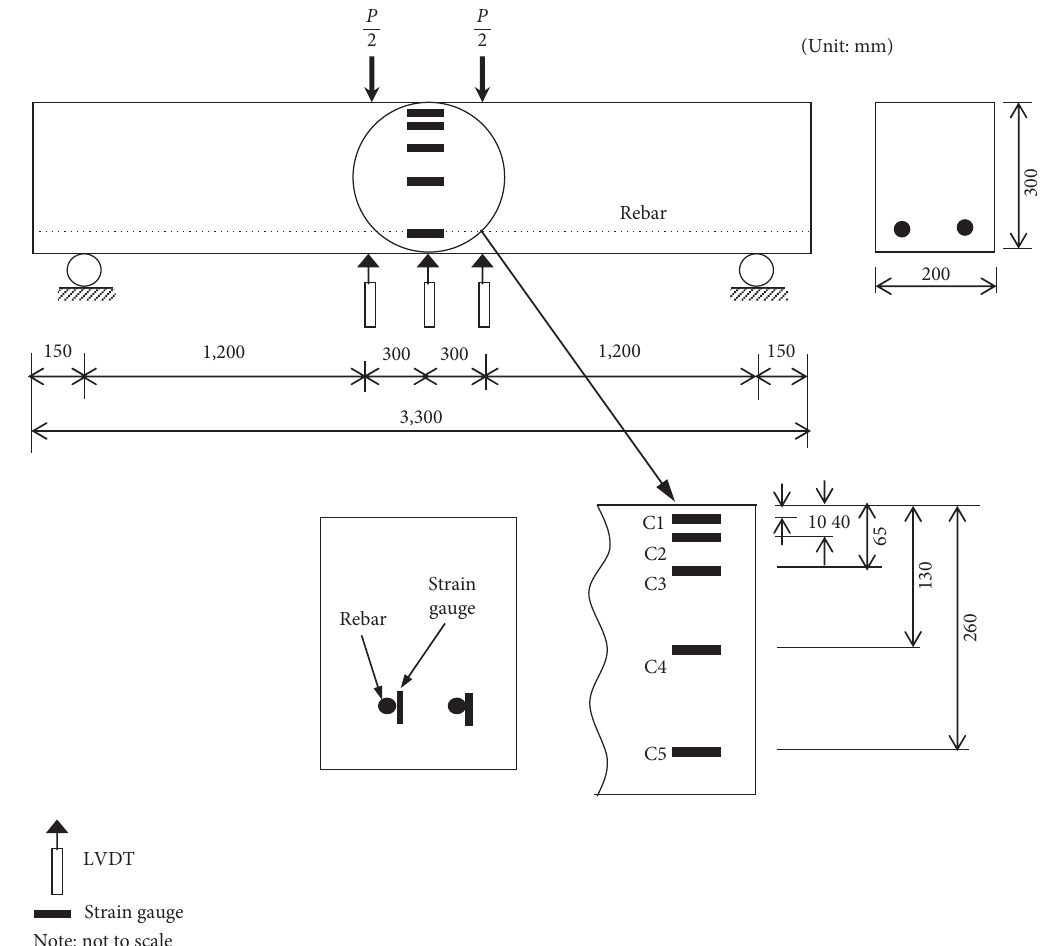
Figure 4: Instrumentation